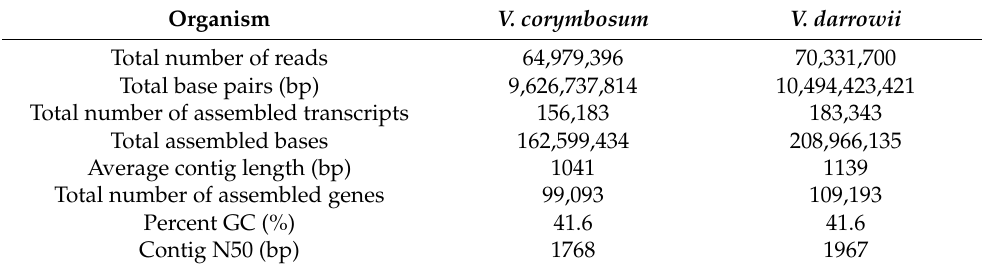
Table 1. Summary of transcriptomes of V. corymbosum and V. darrowii at 0, 6 and 9-h of heat